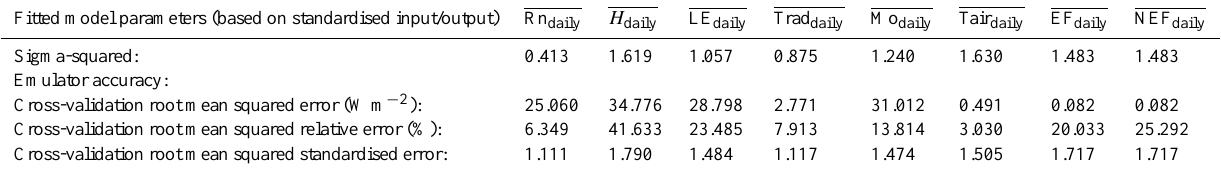
Table 2. Emulator accuracy statistics for the SA tests conducted in our study (under both normal and uniform PDF assumptions for the model inputs/outputs).